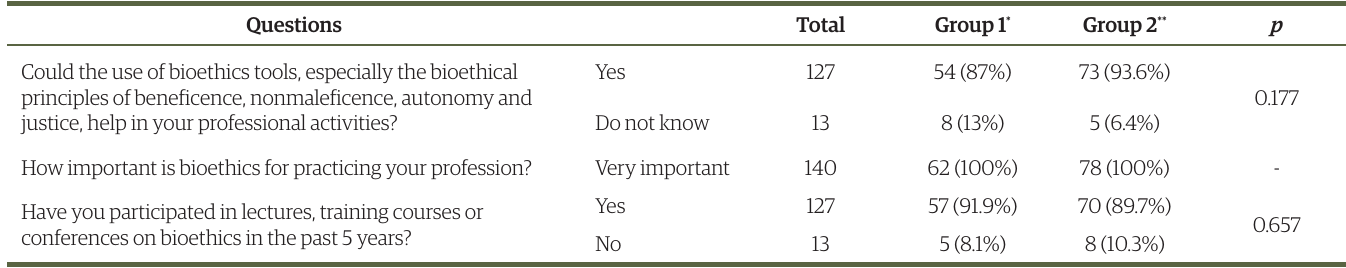
Table 2. Perception of the need for/relevance of bioethics for the profession and participation in events per group. Questions